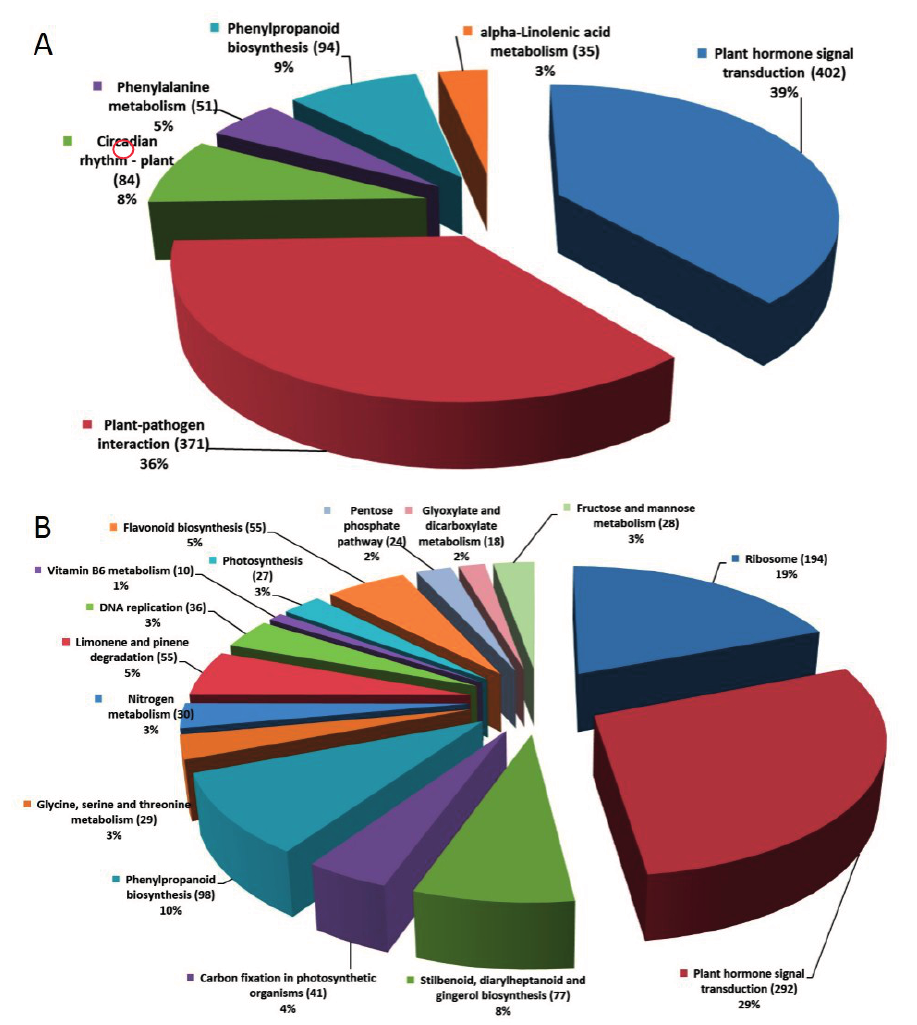
Figure 5. The summary enriched pathways of DEGs in root and leaf. ( A ) CK_root-VS-DS_root DEGs Pathway classification; ( B ) CK_leaf VS DS_leaf DEGs Pathway